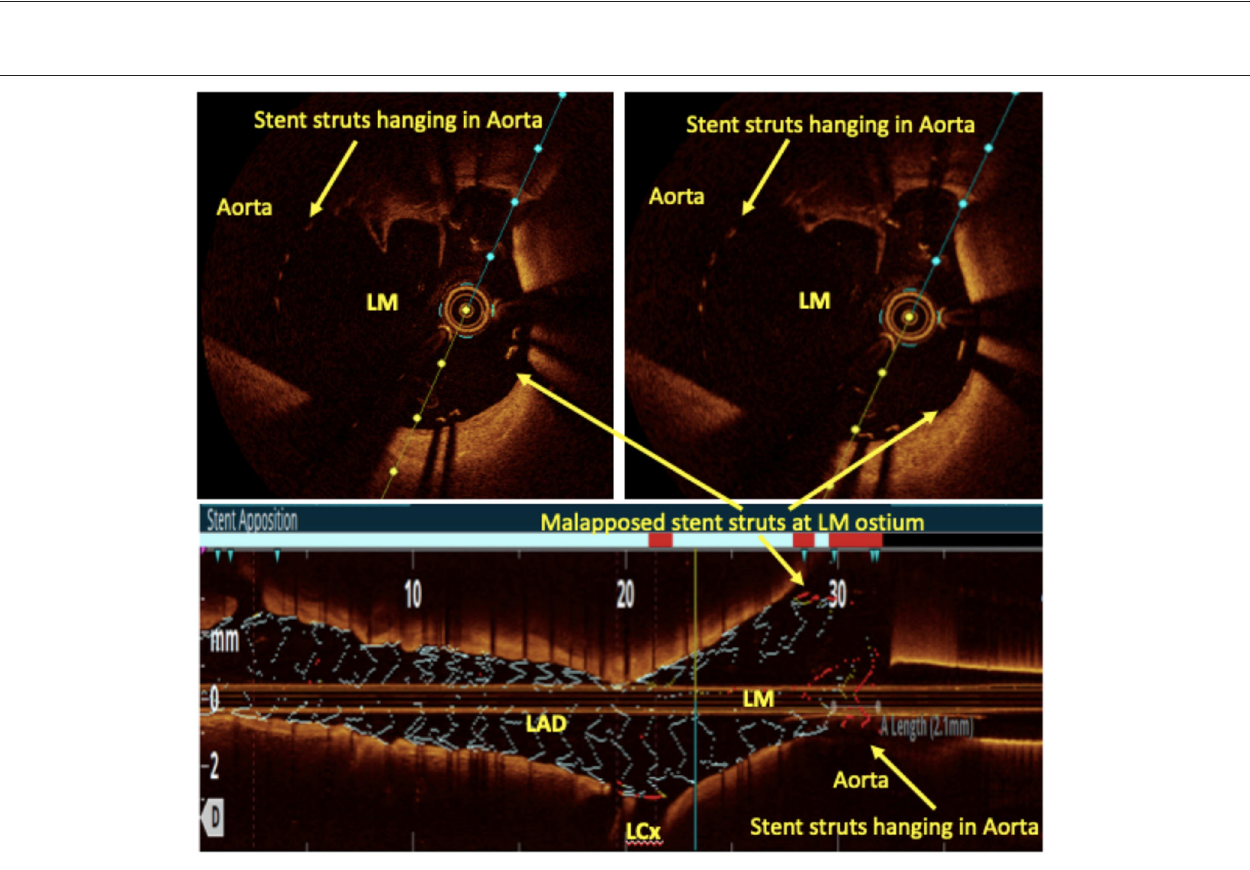
FIGURE 9 | Left main ostial imaging with OCT. OCT pullback from LAD to LM after provisional LM ostial to LAD crossover angioplasty with one wire in the aorta. Hanging stent struts in the aorta (suggestive of LM ostial coverage) can be clearly seen along with some malapposed struts both in the cross-sectional and rendered stent